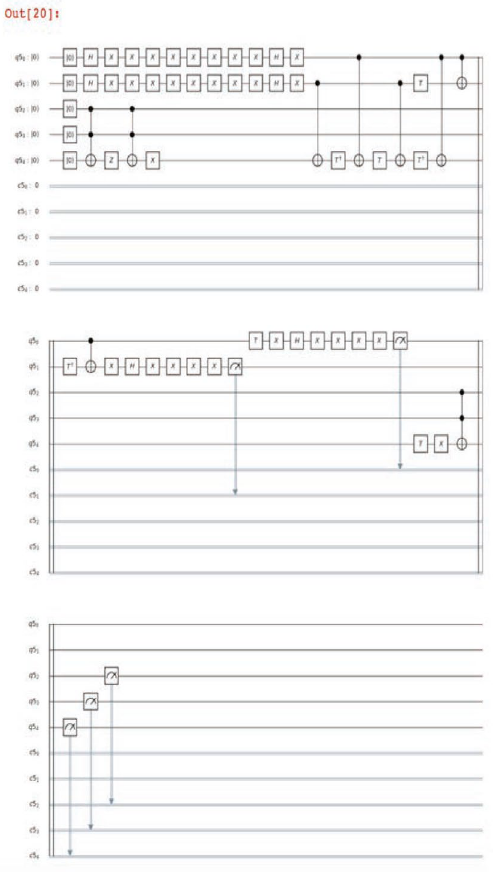
Figure 6. Quantum circuit. A quantum circuit generated in the selection process.